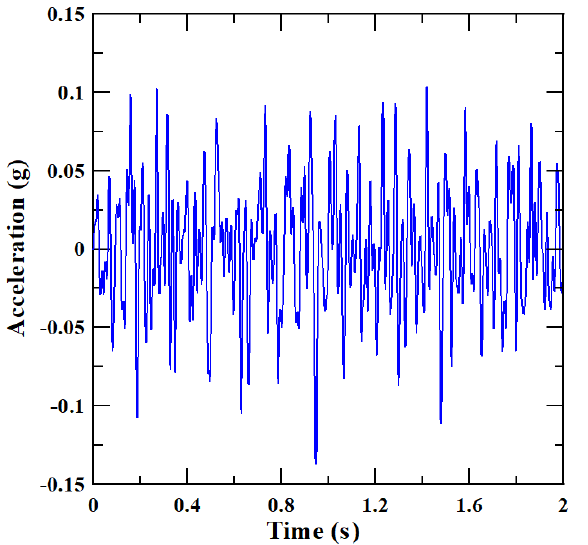
Figure 5: White noise signal from a trial